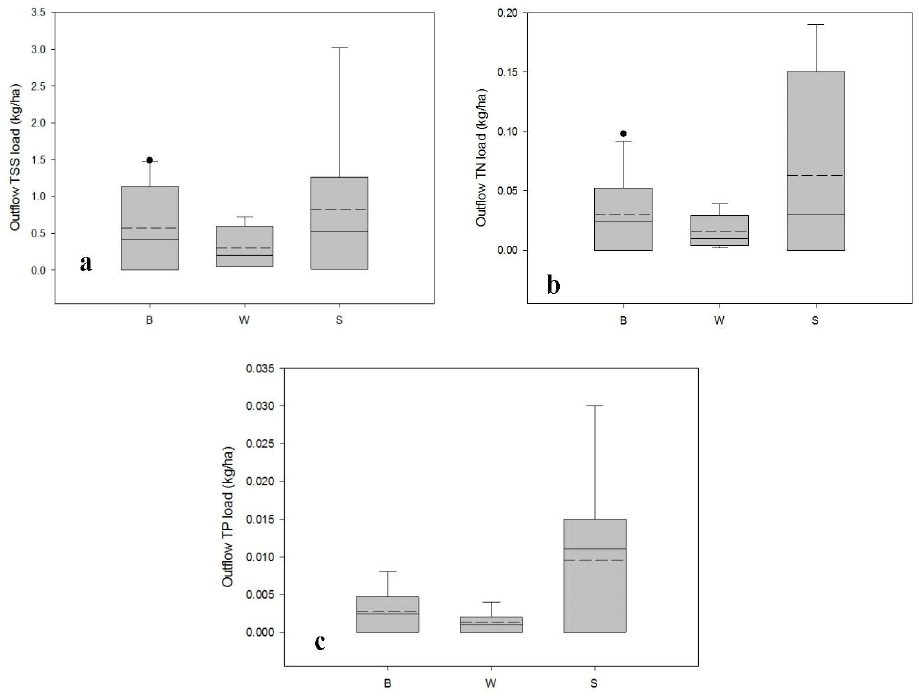
Figure 4. Outflow pollutant loads of WSUDs, ( a ) TSS; ( b ) TN; ( c ) TP. B = bioretention basin; W = constructed wetland; S = roadside swale.